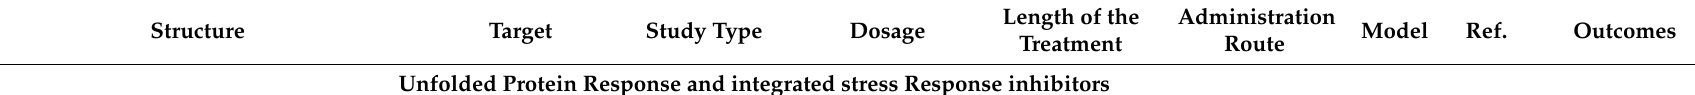
Table 1. List of all the compounds used in DS neuropathology in clinical and preclinical studies acting on the Unfolded and Integrated stress Response, autophagy and ROS. 1 Com-